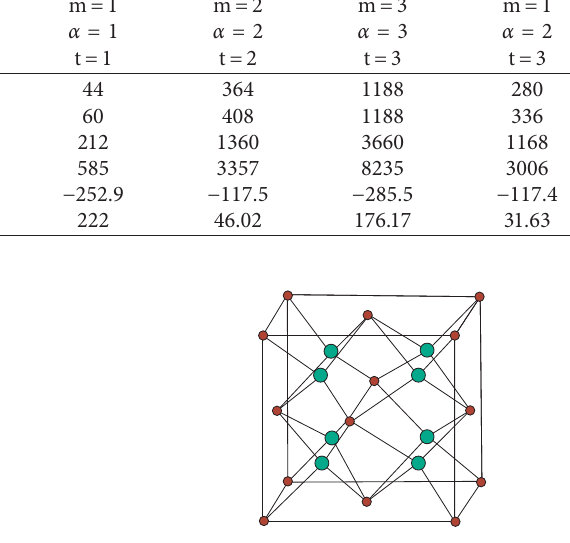
Figure 3: Unit cell of TiF